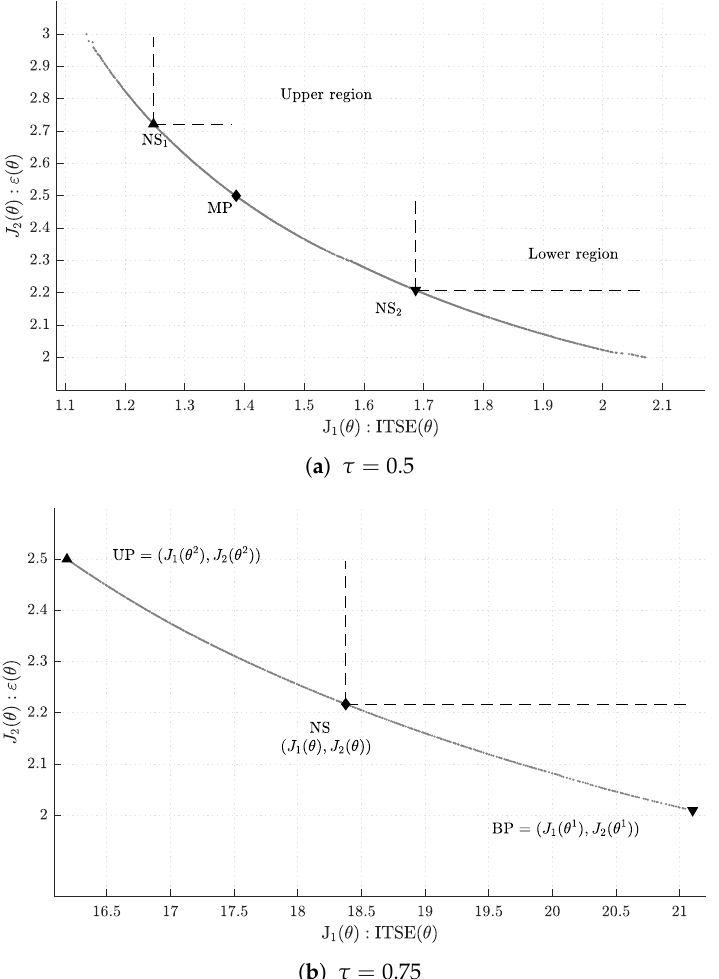
Figure 7. Location of the selected solutions into the Pareto Fronts approximations taking as example two nominal plants. ( a ) For plants in Group 1 , selected solutions are the Nash solution from upper region NS 1 , the midpoint MP, and the Nash solution from lower region NS 2 . ( b ) For plants in Group 2 the selected solutions are the upper end UP, the Nash solution NS, and the bottom end